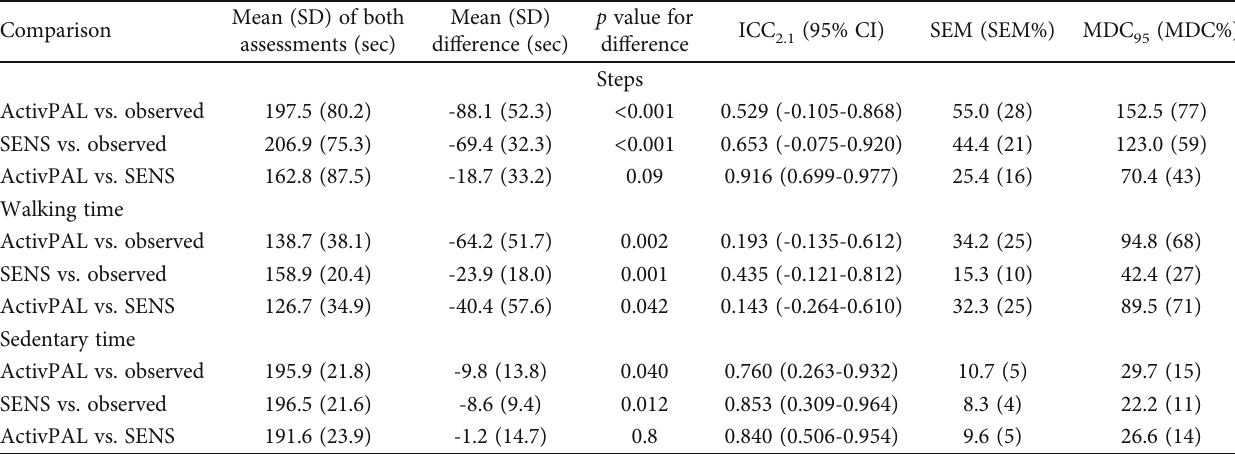
Table 9: Relative and absolute reliability of steps, walking, and sedentary time assessed with ActivPAL3 ™ , SENS motion®, and direct observations in patients following acute high-risk abdominal surgery ( N = 11 ).